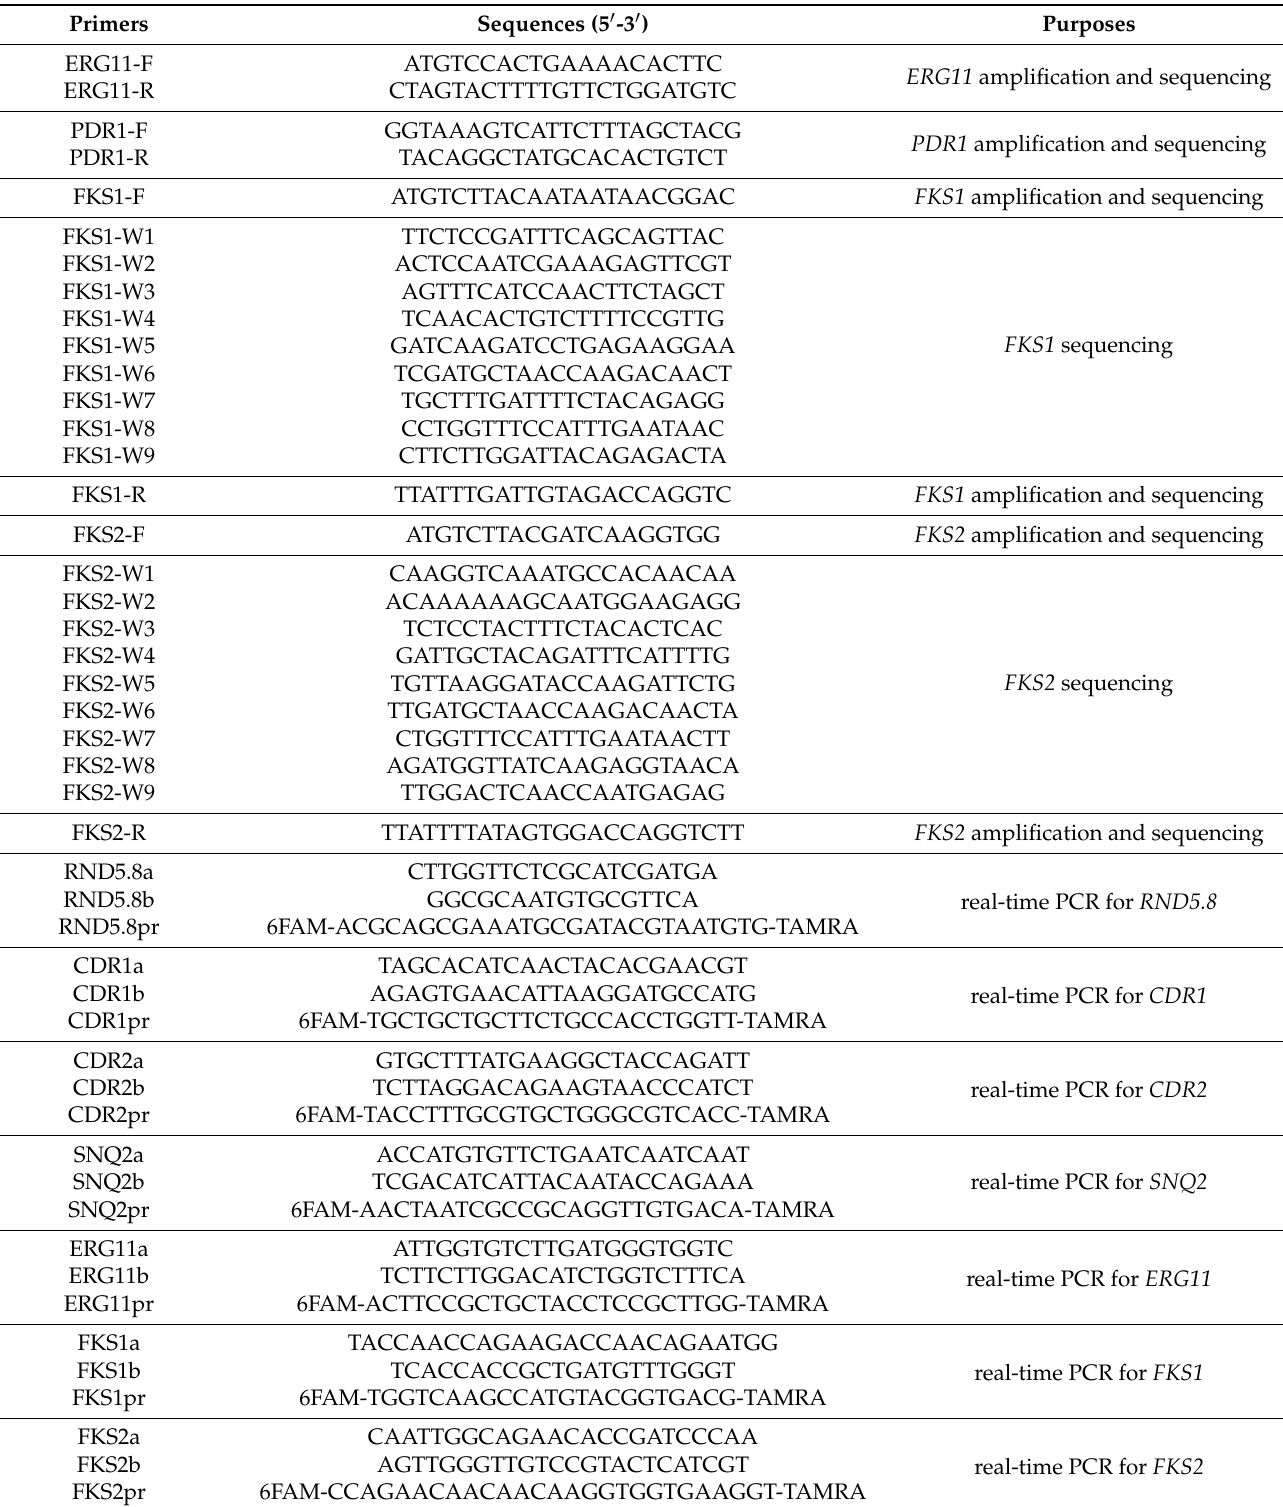
Table 1. Primers and fluorescent probes used in this